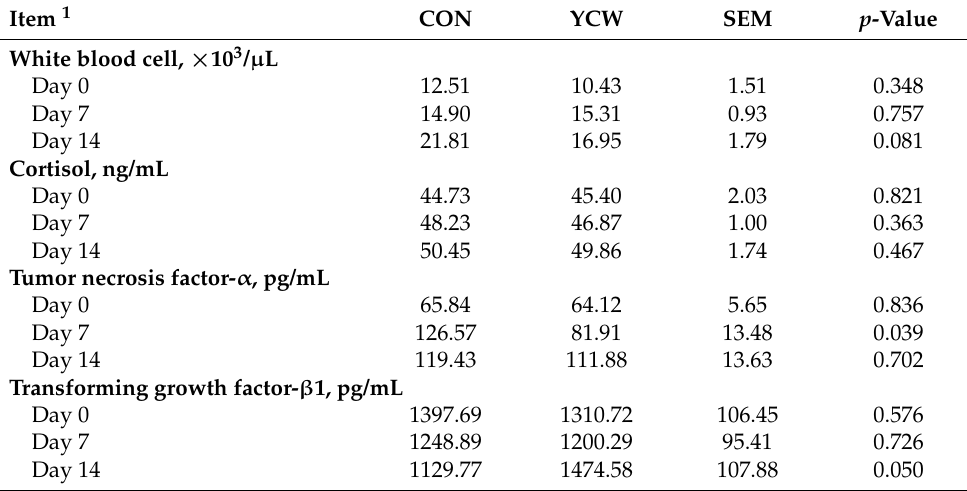
Table 5. Immune responses of weaned pigs fed diets with or without dietary yeast cell